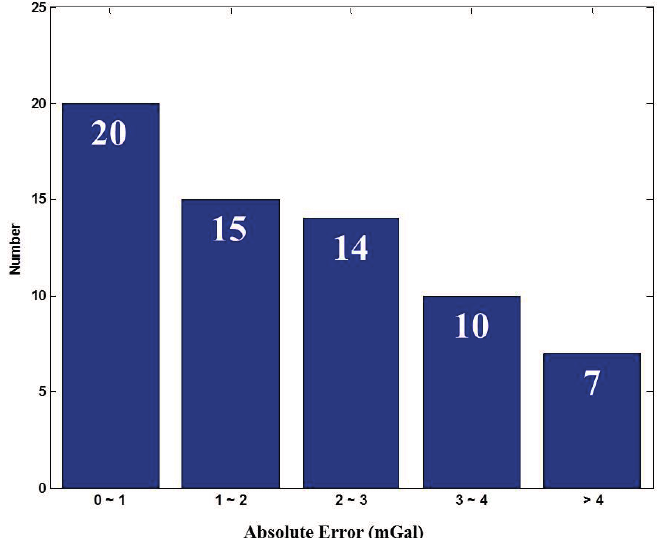
Figure 6. Comparison of the gravity at ZUPT points relative to the previous point derived from iNAV-RQH and Graviton EG.